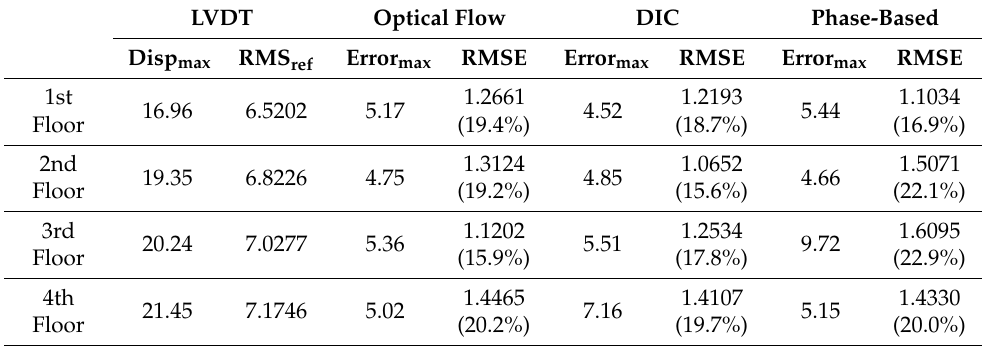
Table 2. RMSE of each story measurement using the proposed three approaches.